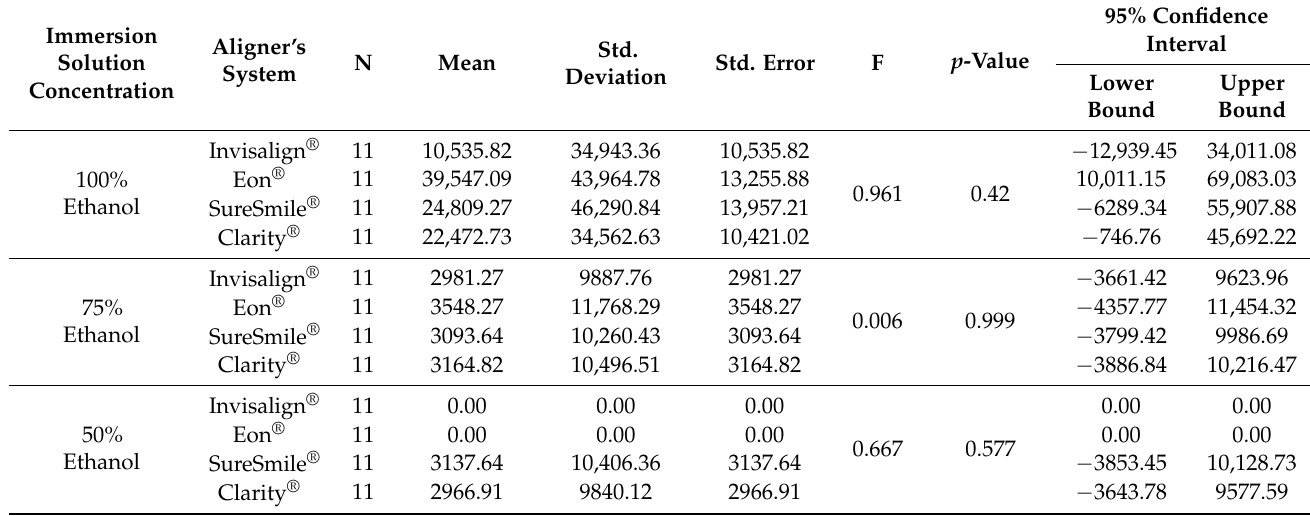
Table 2. Comparison of different systems at variable immersion solution concentrations.